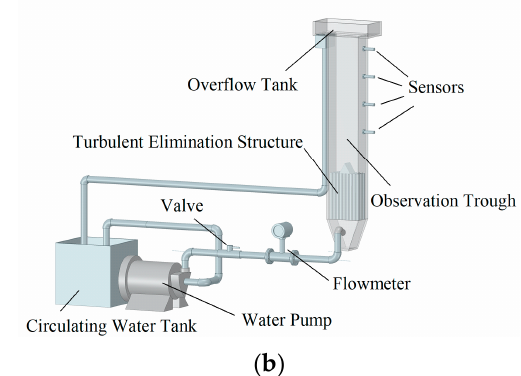
Figure 1. Differential pressure-based concentration detection device and system. ( a ) Differential pressure-based concentration detection device. ( b ) Differential pressure-based concentration detection system.